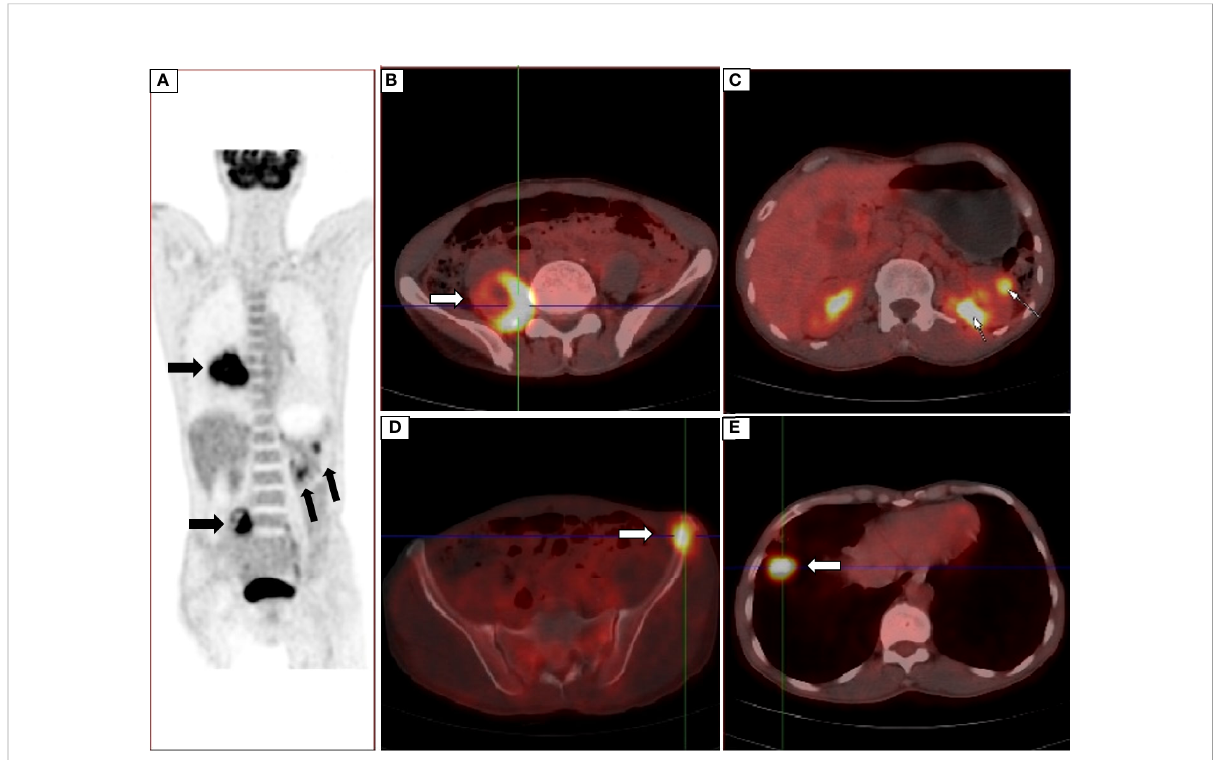
FIGURE 2 PET/CT showed nodules in the right middle and lower lobes near the hilar area (A) the right psoas muscle area (B) and the gastrosplenic space and multiple nodules in the left renal parenchyma (C) uneven density of the left iliac bone (D) multiple round nodules in the right lung (E) and increased FDG metabolism, suggesting malignant